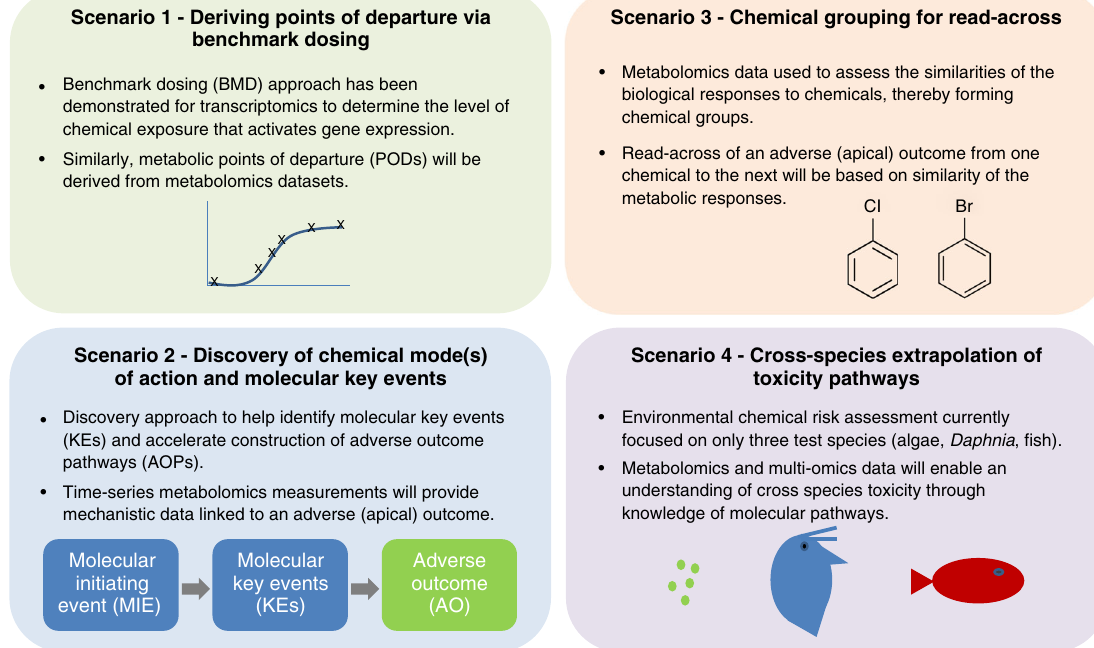
Fig. 2 Four scenarios for the application of metabolomics to regulatory